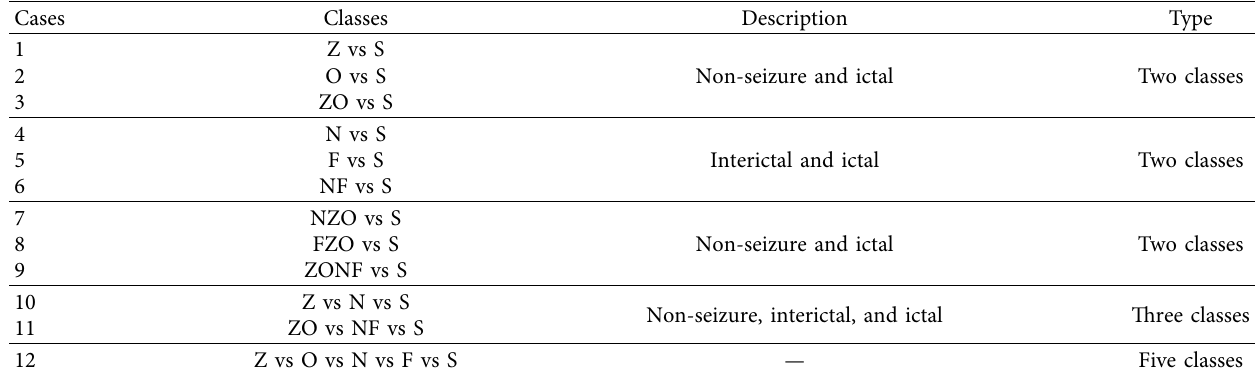
Figure 3: EEG signals from diferent sets of Bonn University dataset. Table 2: Various cases considered in this